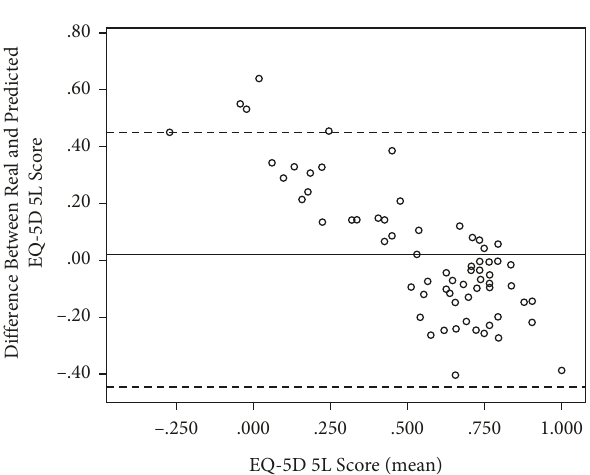
Figure 1: Scatter plot of IKDC score and EQ-5D with the linear line of best fit (solid black line) and the 95% confidence intervals around the mean (dashed lines).